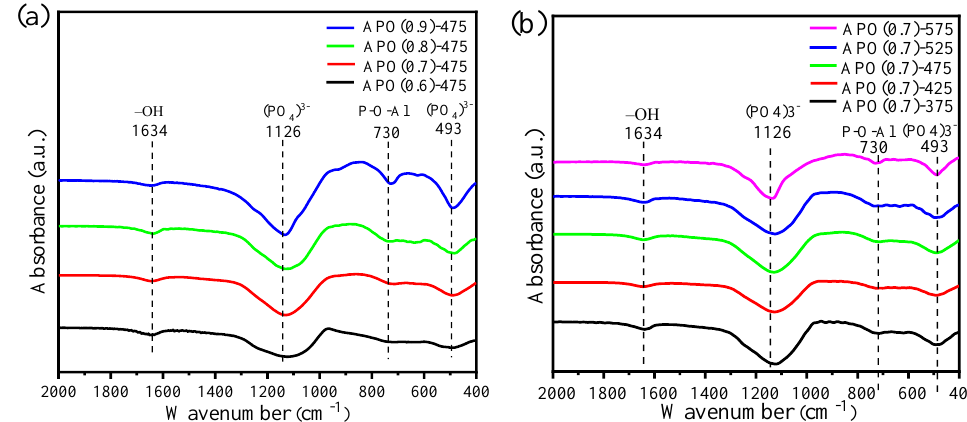
Figure 2. FT-IR spectra of APO catalysts with different ( a ) P/Al molar ratios and ( b ) calcination temperatures.